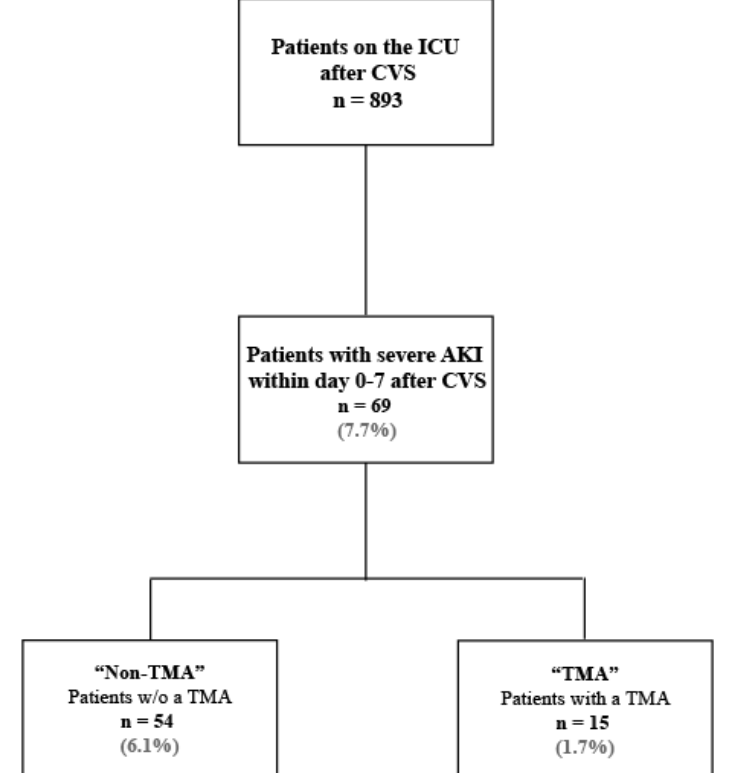
Figure 1. Patients admitted to the CVS unit between January 2018 and March 2019 after a cardiovascular procedure. AKI: acute kidney injury, CVS: cardiovascular surgery, ESKD: end-stage kidney disease, RRT: renal replacement therapy, TMA: thrombotic microangiopathy, w/o: without. N = number of patients, (%) percent out of total number of patients admitted to the ICU after CVS (N = 893).